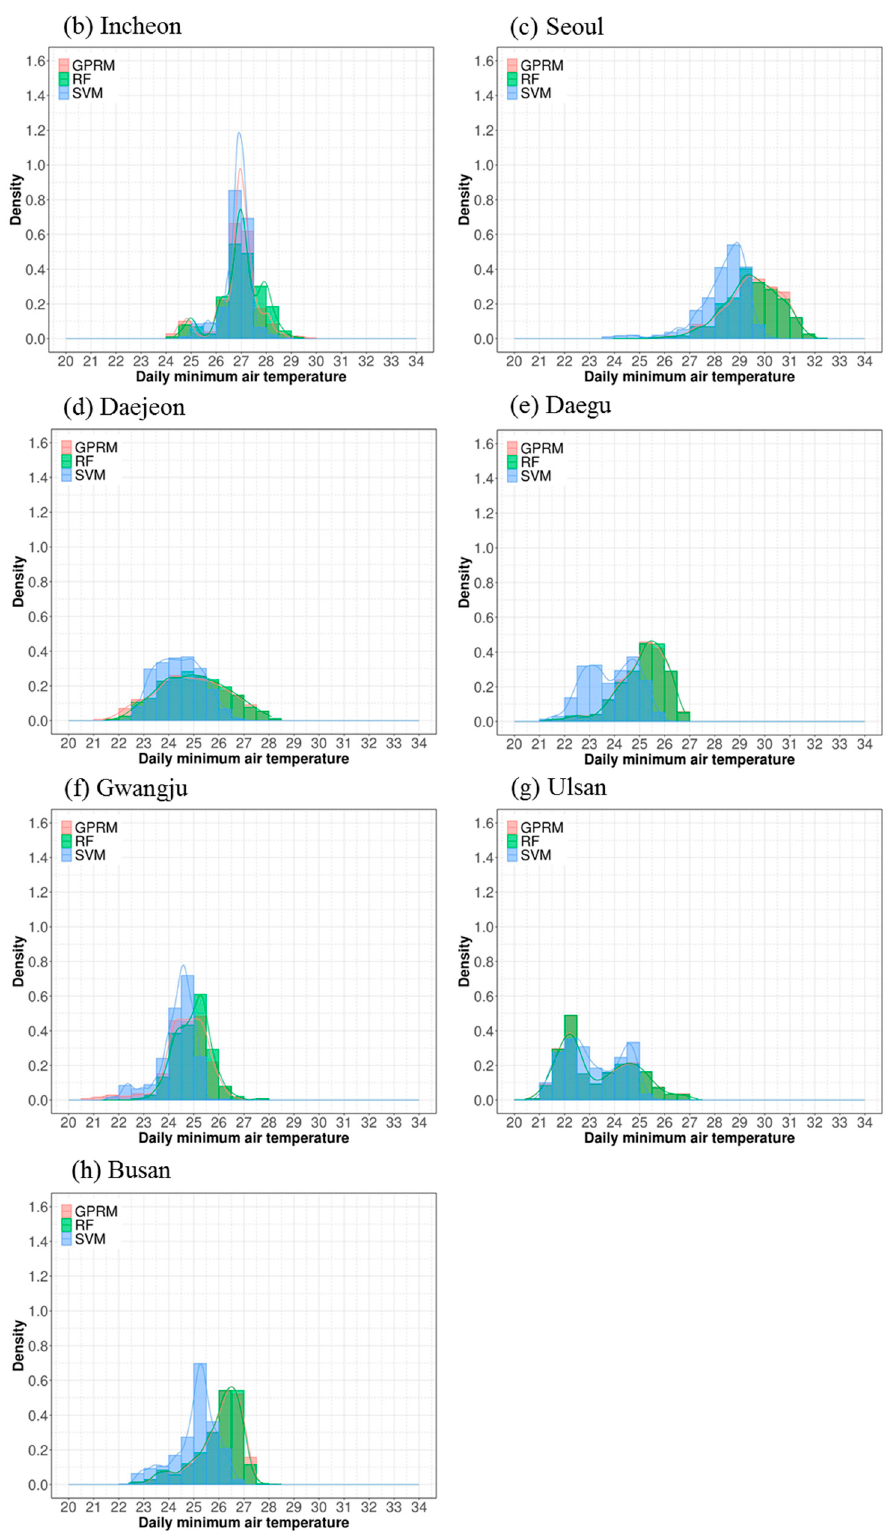
Figure 7. Comparison of daily minimum temperature distributions (on 2 August 2018) with respect to the techniques for a downscaled 1 km resolution. ( b ) Incheon; ( c ) Seoul; ( d ) Daejeon; ( e ) Daegu; ( f ) Gwangju; ( g ) Ulsan; ( h ) Busan. ( b – h ) are the analysis areas shown in Figure 1.